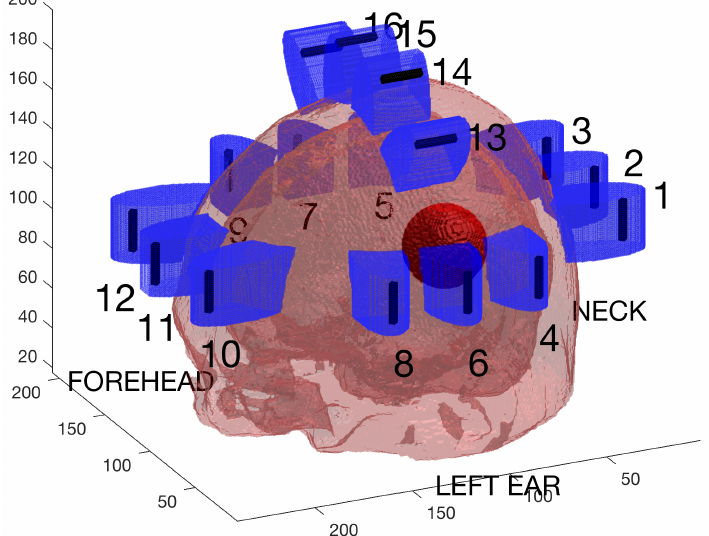
Figure 1. Sixteen antennas were placed around the head model used in the simulations. The figure also shows one example of a spherical bleeding model in dark red color and the containers with deionized water in